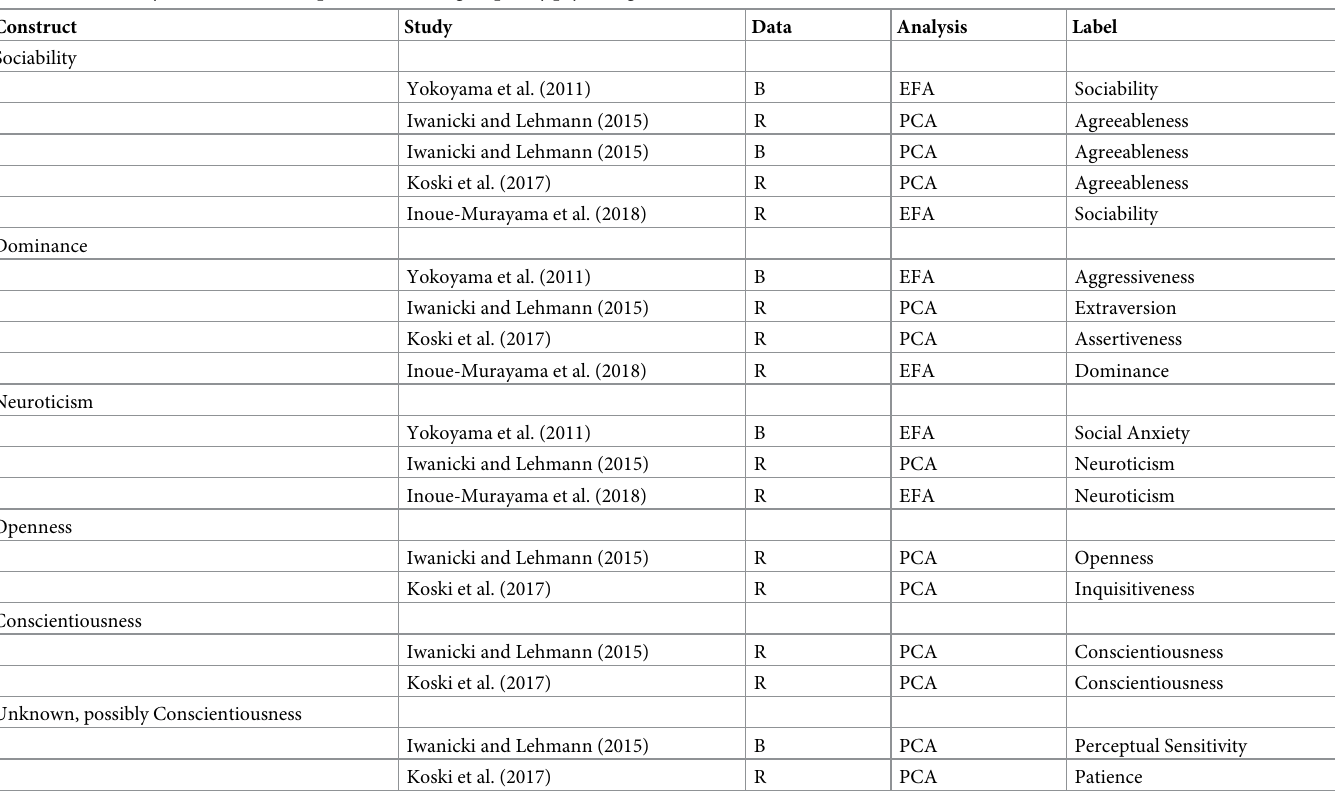
Table 1. Personality domains found in previous studies grouped by psychological construct.